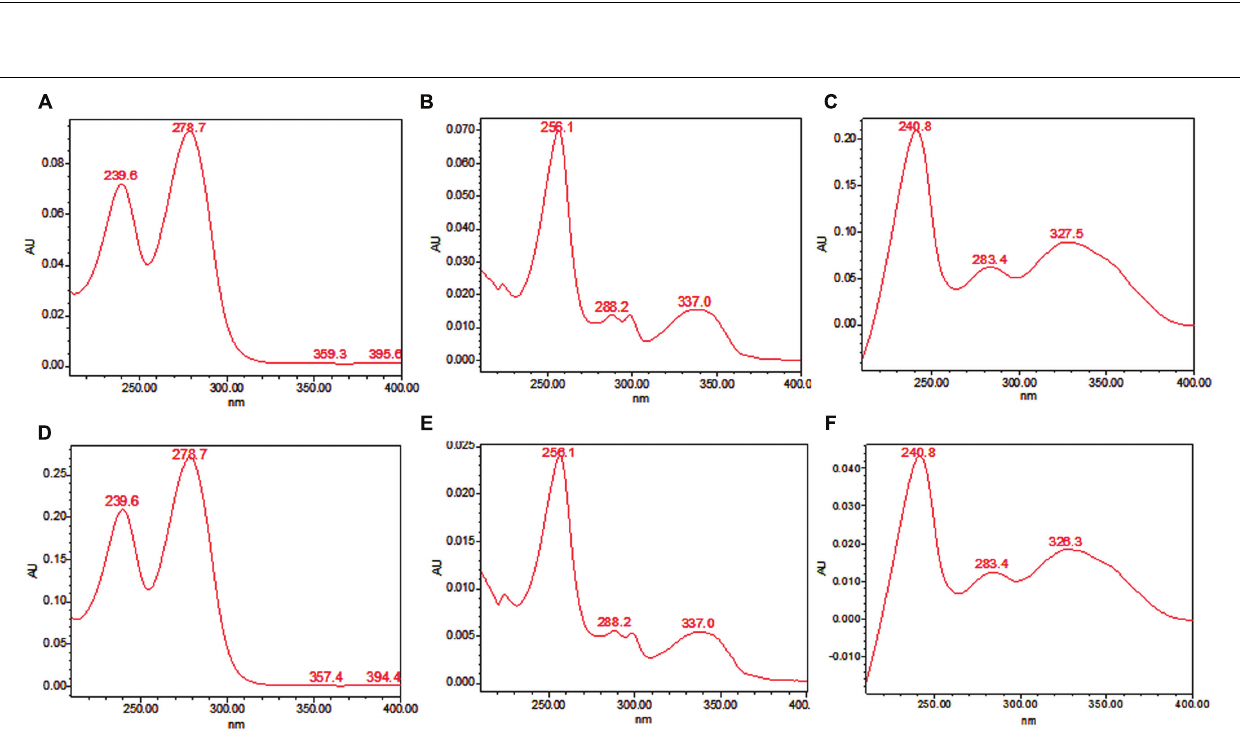
FIGURE 3 | UV absorption spectra recorded for standard metabolites and those isolated from A. alternata using HPLC. (A) absorption peaks for standard TeA at 239.6 nm and 278.7 nm, (B) absorption peaks for standard AOH at 256.1, 288.2, and 337.0 nm, (C) absorption peaks for standard AME at 240.8, 283.4, and 327.5 nm, (D − F) absorbance peaks as evaluated from metabolites TeA, AOH, and AME extracted from fungal